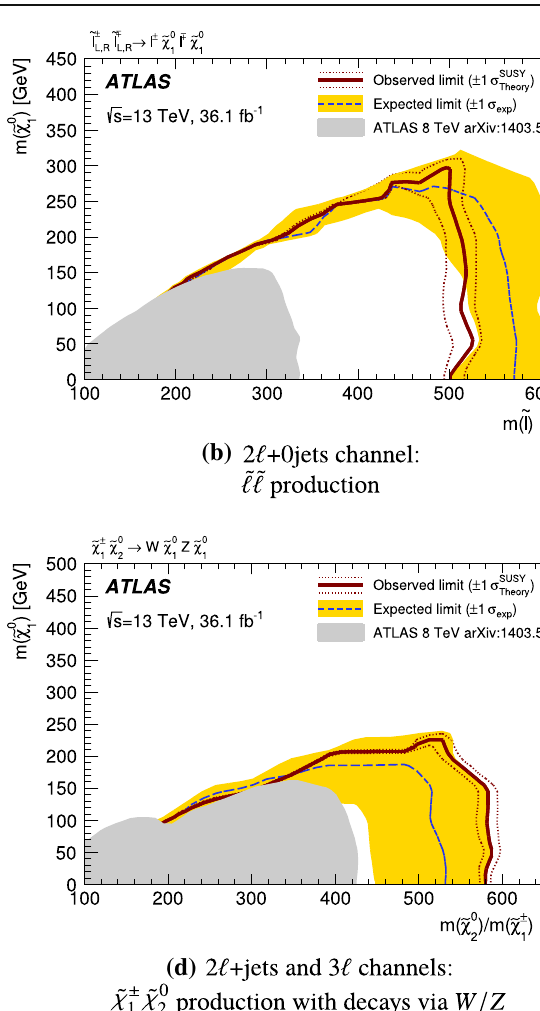
± 1 σ variations in the expected limit, including all uncertainties except theoretical uncertainties in the signal cross-section. The dotted lines around the observed limit illustrate the change in the observed limit as the nominal signal cross-section is scaled up and down by the theoret- ical uncertainty. All limits are computed at 95% confidence level. The observed limits obtained from ATLAS in Run 1 are also shown